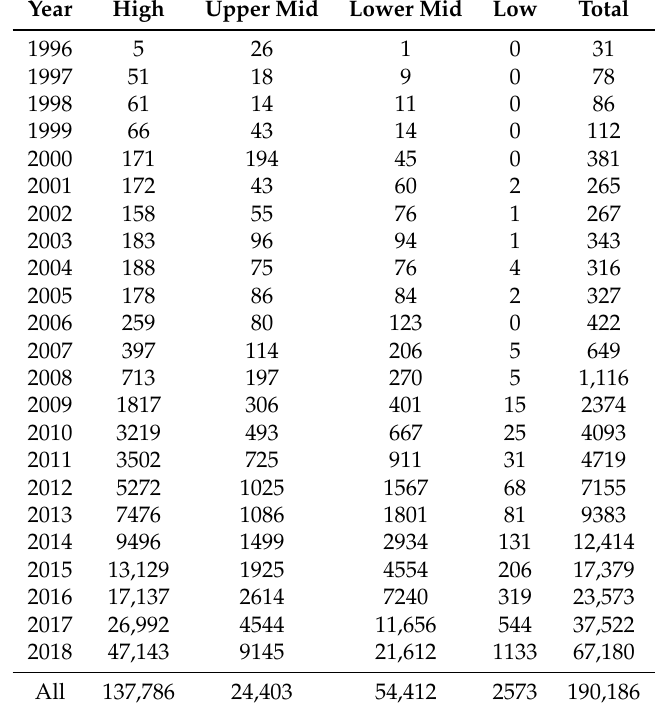
Table 1. This table contains the total number of papers published each year by income group.